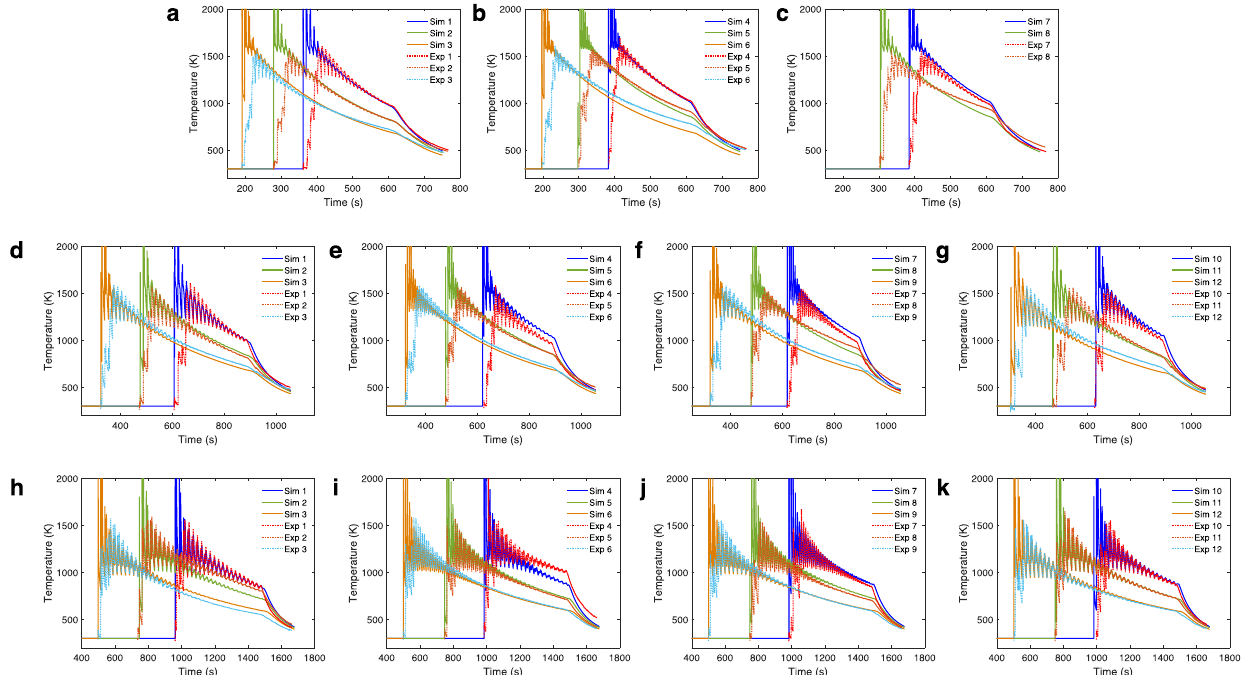
Fig. 2 Comparison of simulated and experimental temperature histories. a – c Case A, 8 specimen locations. d – g Case B, 12 specimen locations. h – k Case C, 12 specimen locations. An enlarged view of h is provided in Supplementary Fig. 2 for clarity. Point locations are labeled in Supplementary Fig. 1 d and e